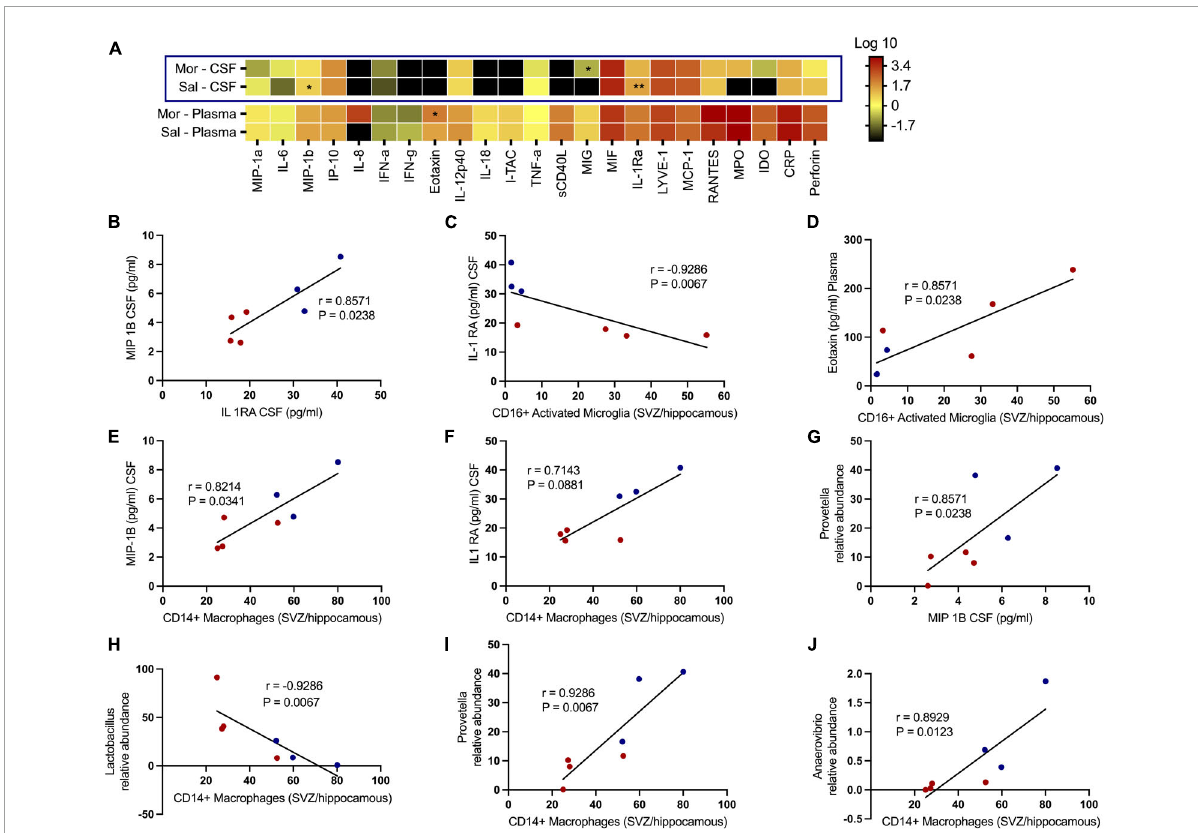
FIGURE7 Morphine dysregulates chemokine and inflammatory cytokine receptors in plasma/the CNS that intercorrelate with CD16+ activated microglia/CD14+ macrophages in sites of neurogenesis and specific genera of the fecal microbiome further offering credence to morphine’s possible effects on interactions of the gut-brain axis. (A) Changes within the CSF and plasma soluble factor profiles of simian human immunodeficiency virus (SHIV) infected rhesus macaques exposed to either morphine or saline. Multiple correlations between diverse parameters of the fecal microbiome, brain immune cells and CSF/plasma soluble factor indices as shown by relationships between (B) MIP-1B CSF (pg/ml) and IL-1 RA CSF (pg/ml). (C) IL-1 RA CSF (pg/ml) and CD16+ activated microglia [subventricular zone (SVZ)/hippocampus]. (D) Eotaxin plasma (pg/ml) and CD16+ activated microglia [(SVZ)/hippocampus]. (E) MIP-1B CSF (pg/ml) and CD14+ macrophages [(SVZ)/hippocampus]. (F) IL-1 RA CSF (pg/ml) and CD14+ macrophages [(SVZ)/hippocampus]. (G) Prevotella relative abundance and MIP-1B CSF (pg/ml). (H) Lactobacillus relative abundance and CD14+ macrophages [(SVZ)/hippocampus]. (I) Prevotella relative abundance and CD14+ macrophages [(SVZ)/hippocampus]. (J) Anaerovibrio relative abundance and CD14+ macrophages [(SVZ)/hippocampus]. p < 0.05 is considered statistically significant. (Red dot points signify morphine treated SIV infected rhesus macaques whilst blue dot points are saline treated SIV infected rhesus macaques). (* p < 0.05, ** p < 0.01, using the Spearman’s rank correlation